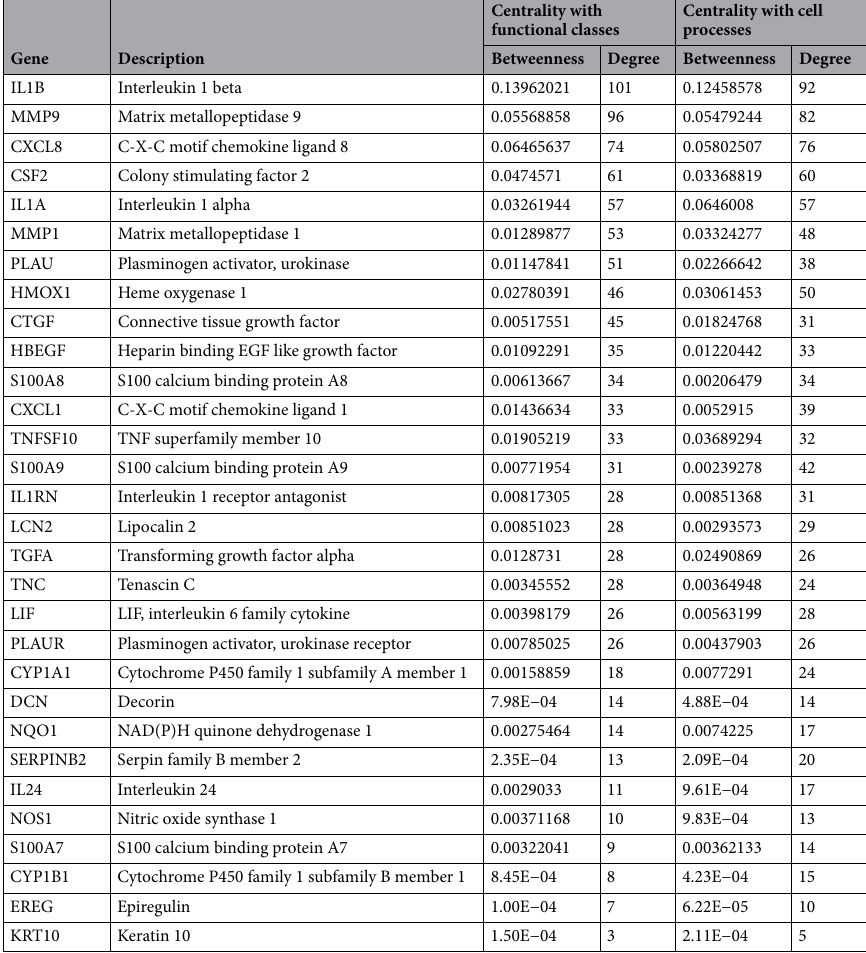
Table 3. Profiles of the 30 genes were identified through NGS experiment-based analysis and used to construct the significant signaling